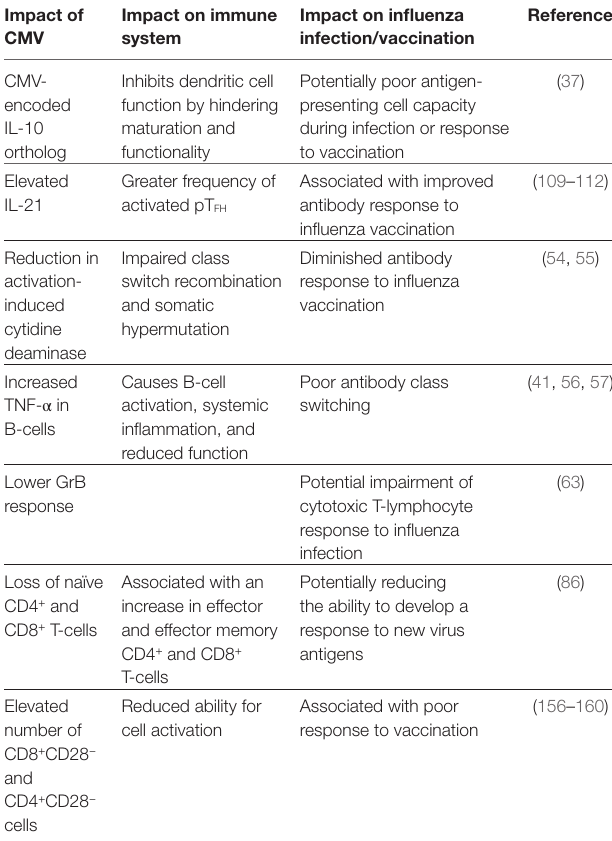
TABLe 1 | Summary of the impact of cytomegalovirus (CMV) in the elderly and resulting influence on the response to influenza infection and vaccination. impact of